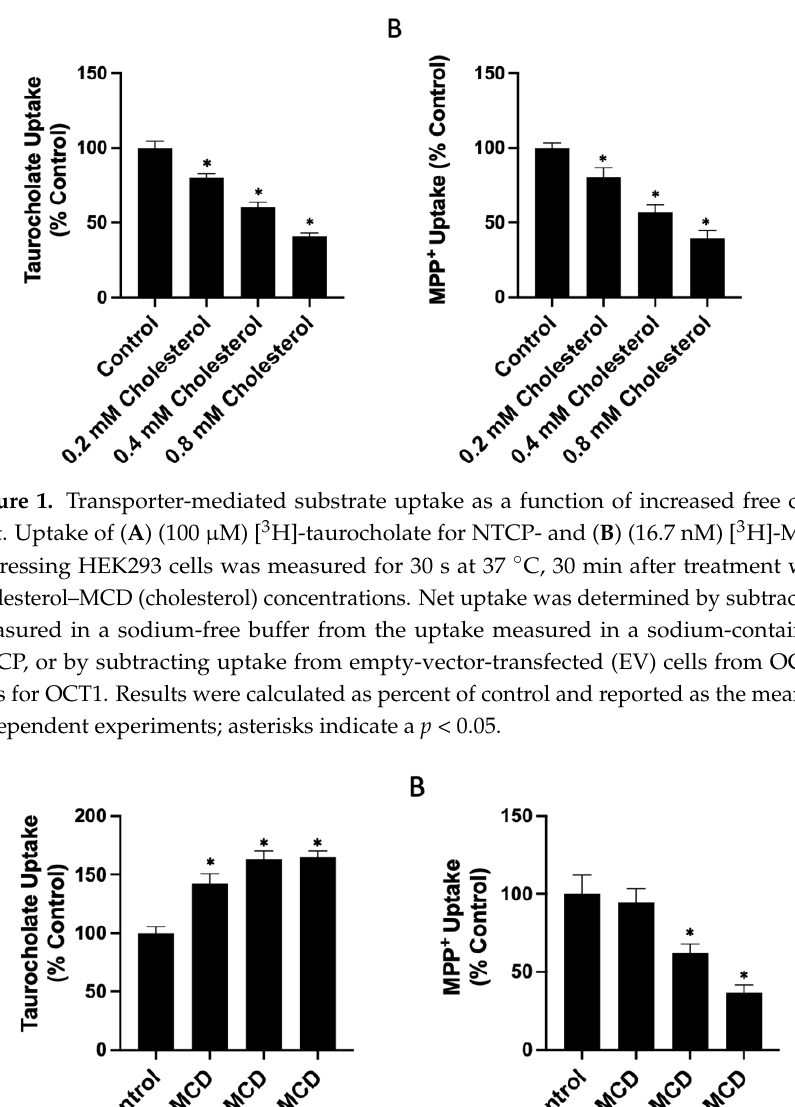
the functional changes seen in Figures 1 and 2 correlate with the altered plasma membrane free cholesterol content.